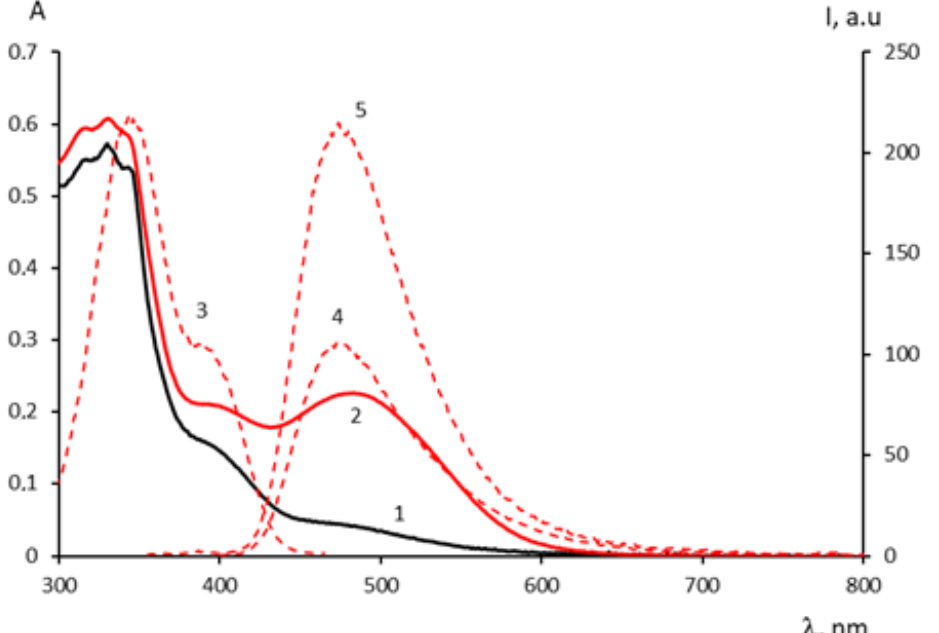
Figure 7. Absorption spectra (1, 2), fluorescence excitation spectrum at λ reg = 475 nm (3) and fluorescence spectra at λ ex = 390 nm (4) and 345 nm (5) before (1) and after UV irradiation (2–5) of compound 1 in the mixed solvent solution preliminary UV irradiated, kept in the dark and finally with Mg 2+ ions added.